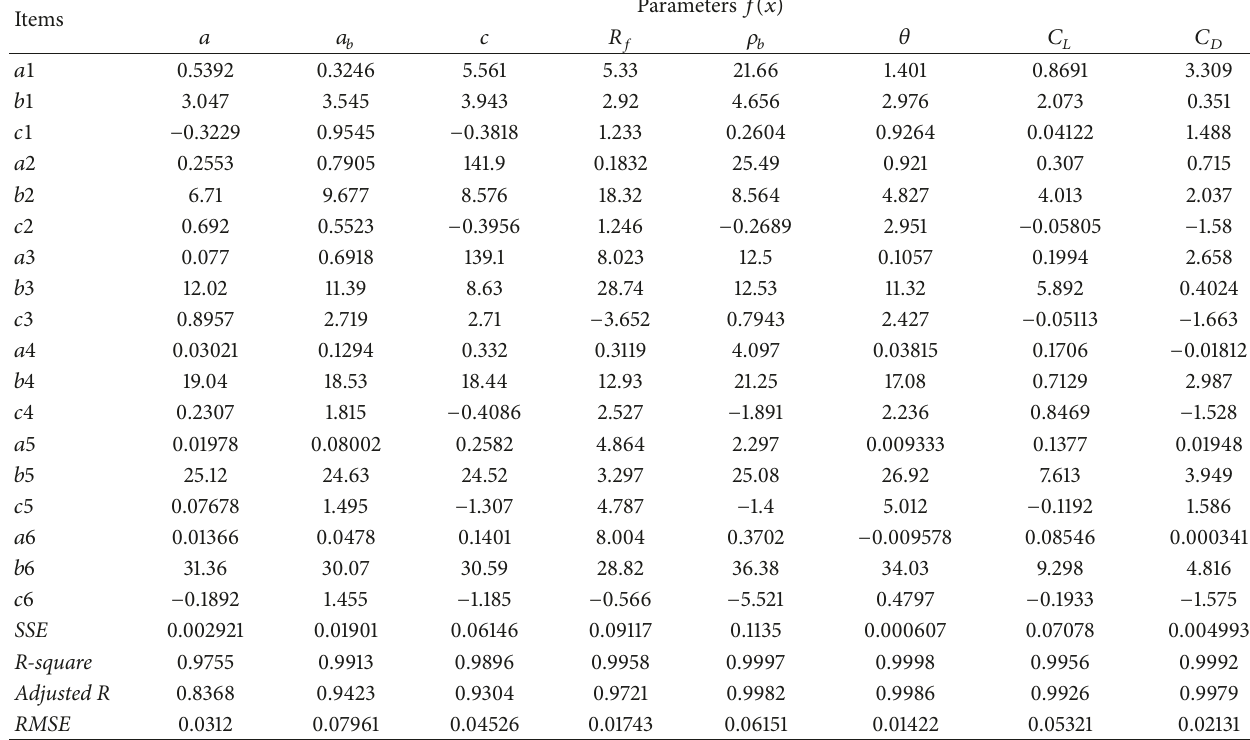
Table 1: Coefficients and errors of the fitted